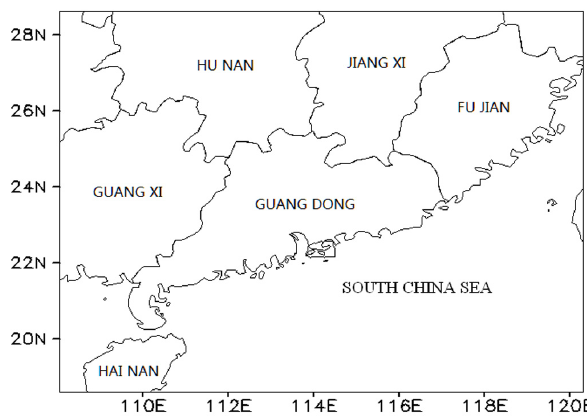
Fig. 1b. Map of PRD area. The measurement sites are